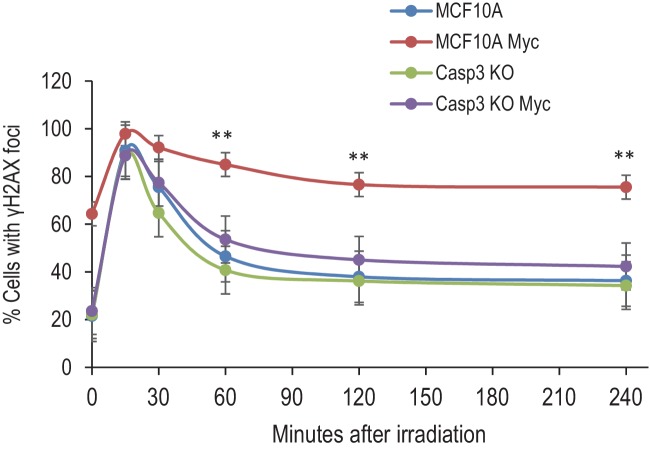
DNA double-strand repair kinetics in MCF10A cells with various genetic backgrounds.Cells were synchronized and irradiated with 3Gys of X-rays. At different time points after radiation exposure, they were fixed and stained with fluorescence-labeled γH2AX antibody. The fraction of cells with γH2AX foci were then enumerated from fluorescence images. MCF10A Myc vs Casp3KO Myc, **p<0.001, n = 5, Student’s t-test.